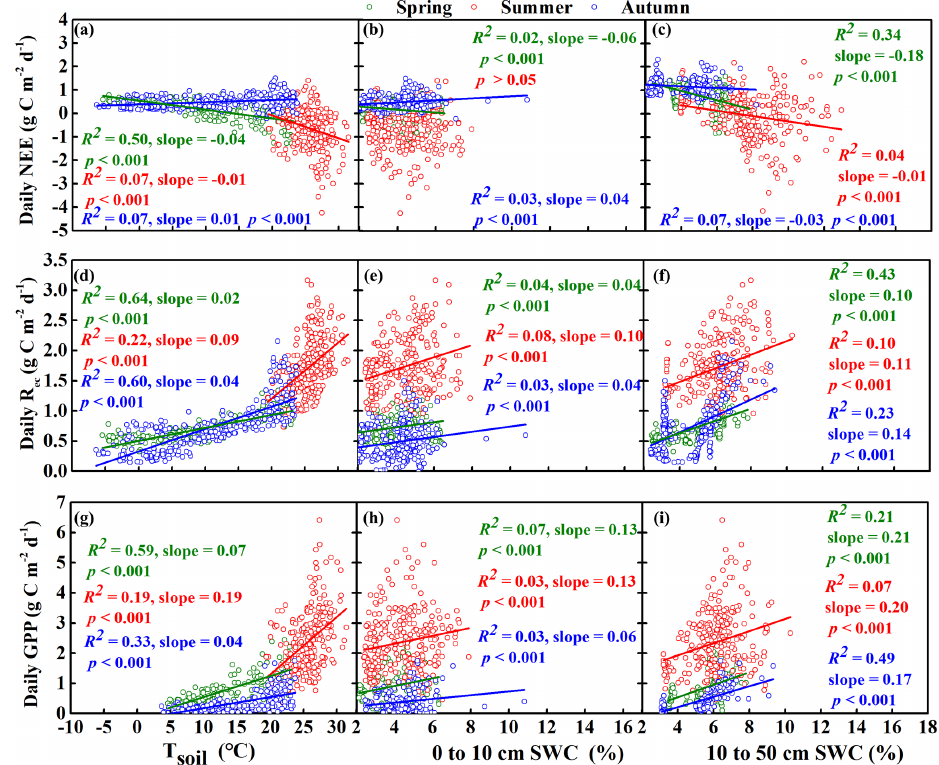
Figure 8. Relationships between daily net ecosystem carbon exchange (NEE), gross primary productivity (GPP), and ecosystem respiration ( R ec ) and the average soil temperature to a depth of 50cm ( T soil ) and soil water content (SWC). Before the regression analysis, SWC was divided into two depth ranges: the near-surface soil (0 to 10cm) and deeper soil (10 to 50cm). However, NEE was only correlated with SWC at depths of 40 and 50cm in the summer and 20 and 30cm in the autumn based on the results of a collinearity test for the three seasons. T soil was divided into a single range (0 to 50cm) based on the results of a collinearity test for the three seasons: spring (March–April–May), summer (June–July–August), and autumn